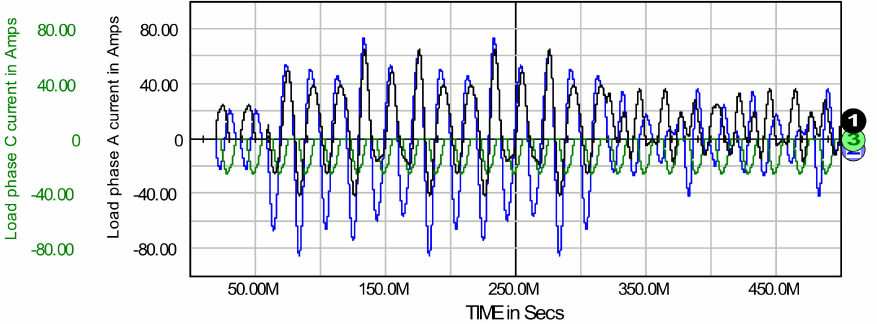
Figure 13. Load phase currents of phase A, B, and C as waveforms 1, 2, and 3, respectively. The load passive part is switched on at t 1 = 20 ms, and the generative part is activated at t 2 = 60 ms and deactivated at t 3 = 320 ms.